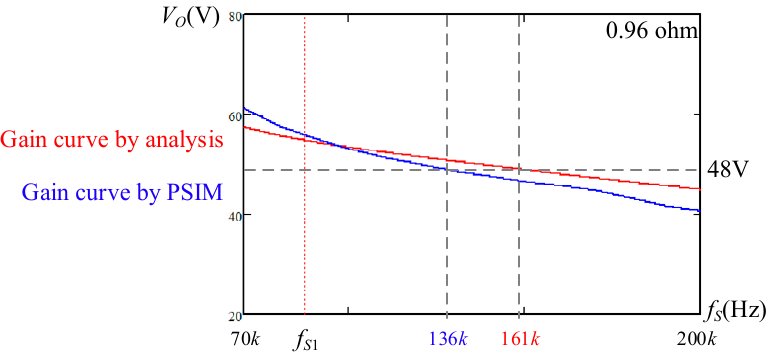
Figure 19. Gain curve comparison at 50% load.